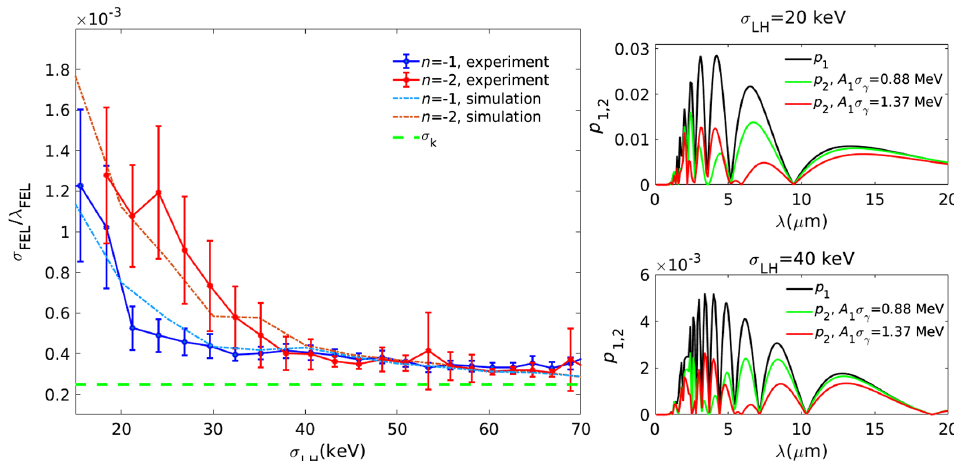
FIG. 2. Left: Relative FEL rms spectral bandwidth vs LH-induced energy spread. Blue and red lines are experimental data (solid) and theoretical prediction [dashed-dotted, Eq. (8)] for n ¼ − 1 and n ¼ − 2 , respectively. EEHG is tuned at λ line is from Eq. (6). In case of n ¼ − 1 , the first seed energy is 8 . 3 μ J ( A 1 σ E ¼ 0 . 88 MeV) and for n ¼ − 2 , it is 20 μ J ( A 1 σ E ¼ 1 . 37 MeV). Right: calculated energy modulation amplitude p 1 ð λ μ Þ and p 2 ð λ μ Þ from MBI modeling for σ (top) and 40 keV